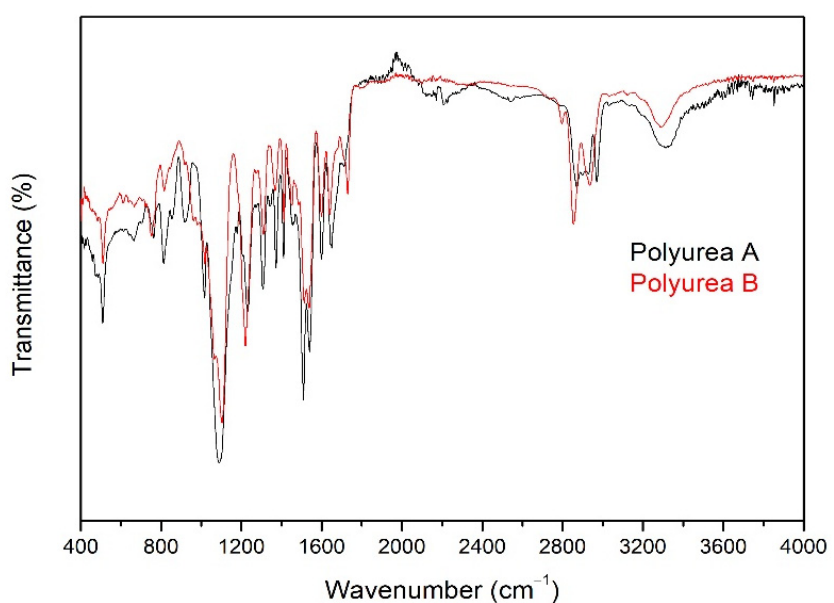
Figure 2. Comparison of FTIR spectra of polyureas A and B.